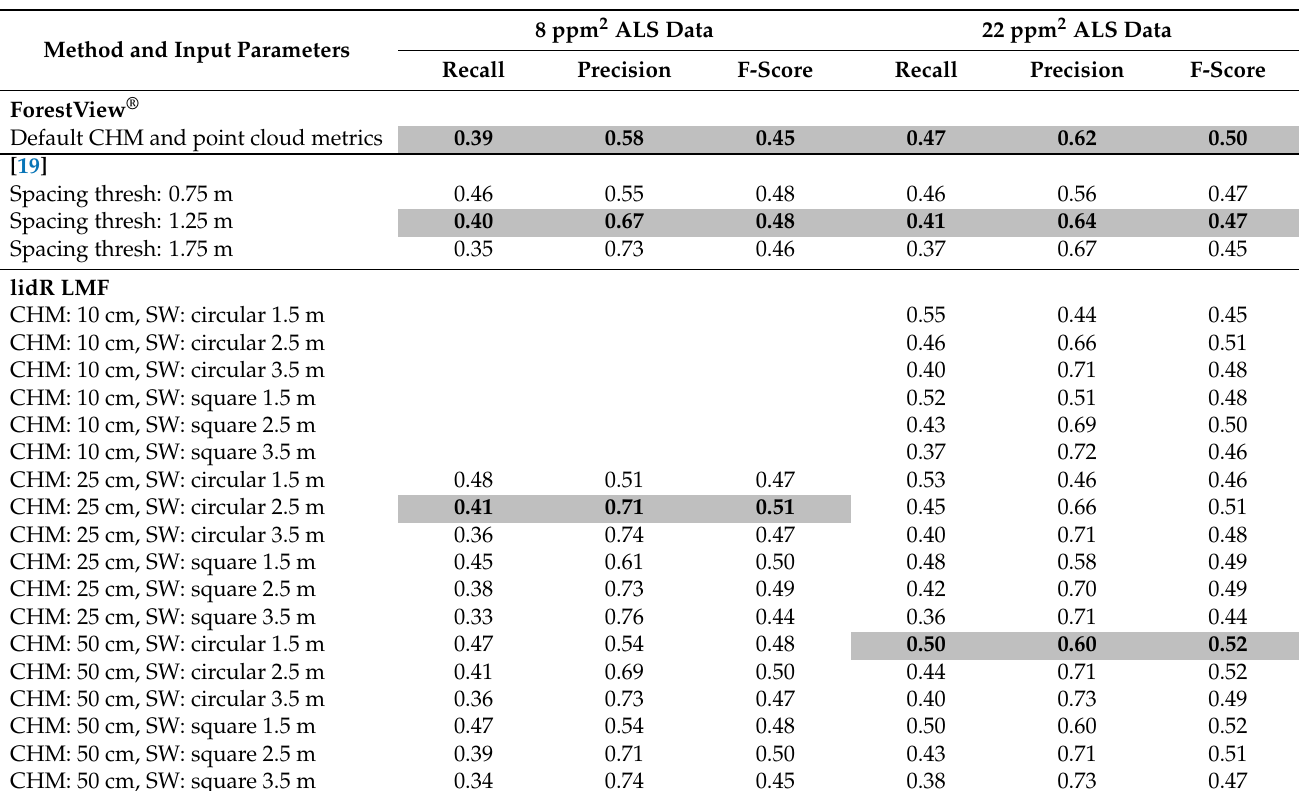
Table 4. ITD accuracy for all method approaches in terms of recall, precision, and F-score. The highest accuracy approaches for each ITD method are bolded and filled in grey. CHM = canopy height model, SW = search